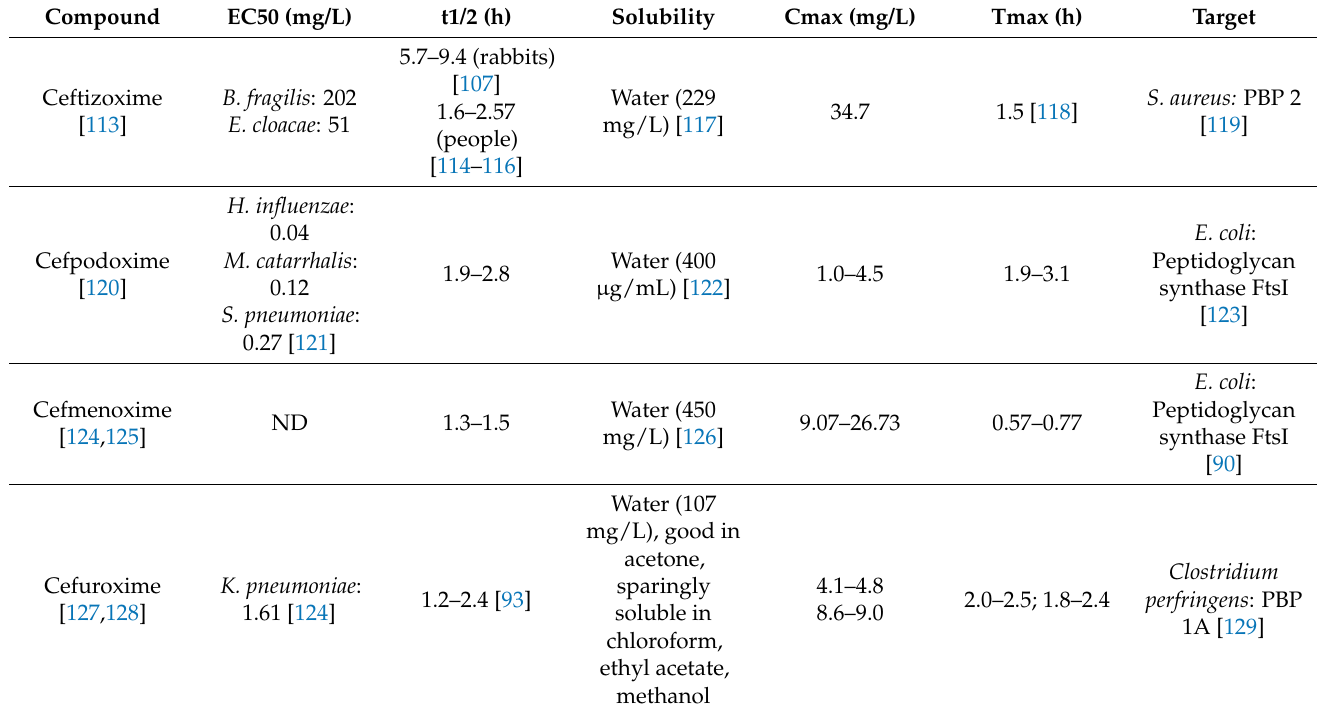
Table 3. Pharmacokinetic parameters of the FDA-approved oximes. (t 1/2 : half-life excretion time; C max : maximum concentration in blood plasma; and T max : time to reach C max